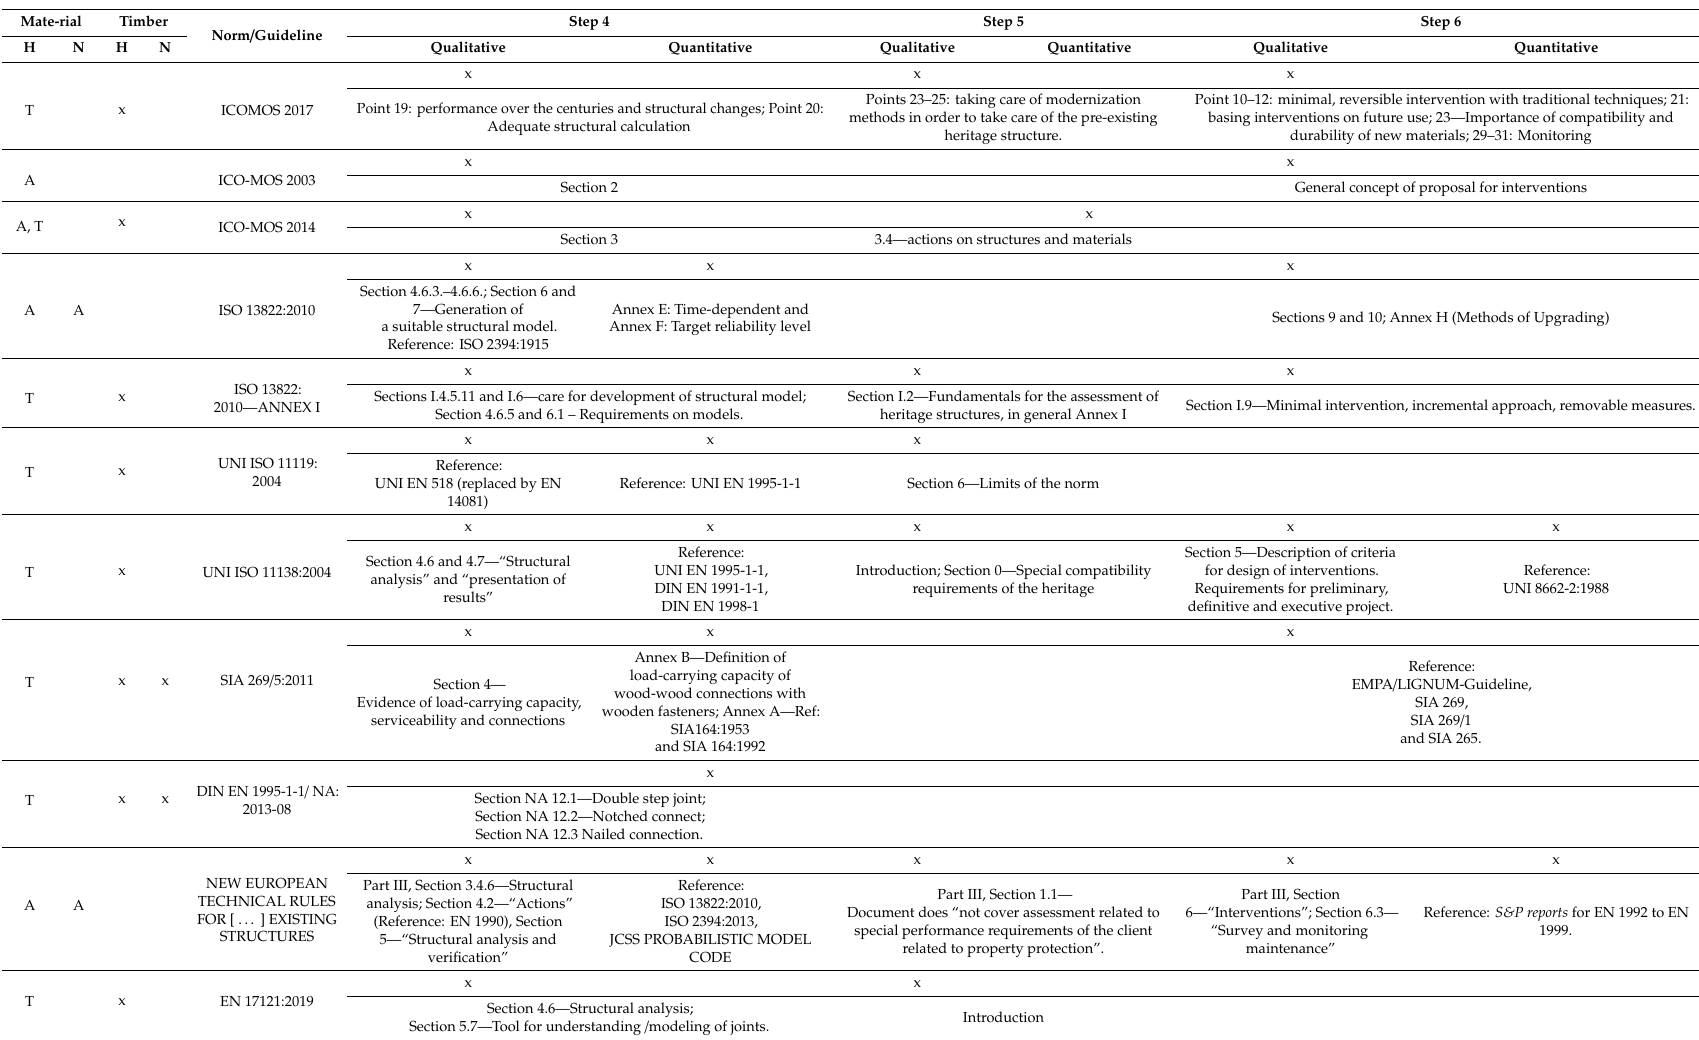
Table 3. R é sum é of the content of the analyzed standards—Step 4 to Step